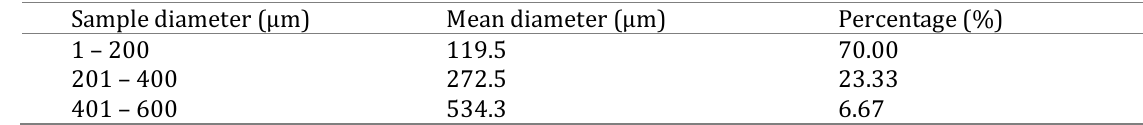
Table 1 : Particle size distribution of the milled and sieved polyethylene microplastics. The FESEM imaging was conducted four times and the particle diameters were grouped into three categories (1 – 200 µm, 201 – 400 µm and 401 – 600 µm). The mean diameters of the particles were measured with the FESEM measuring software.